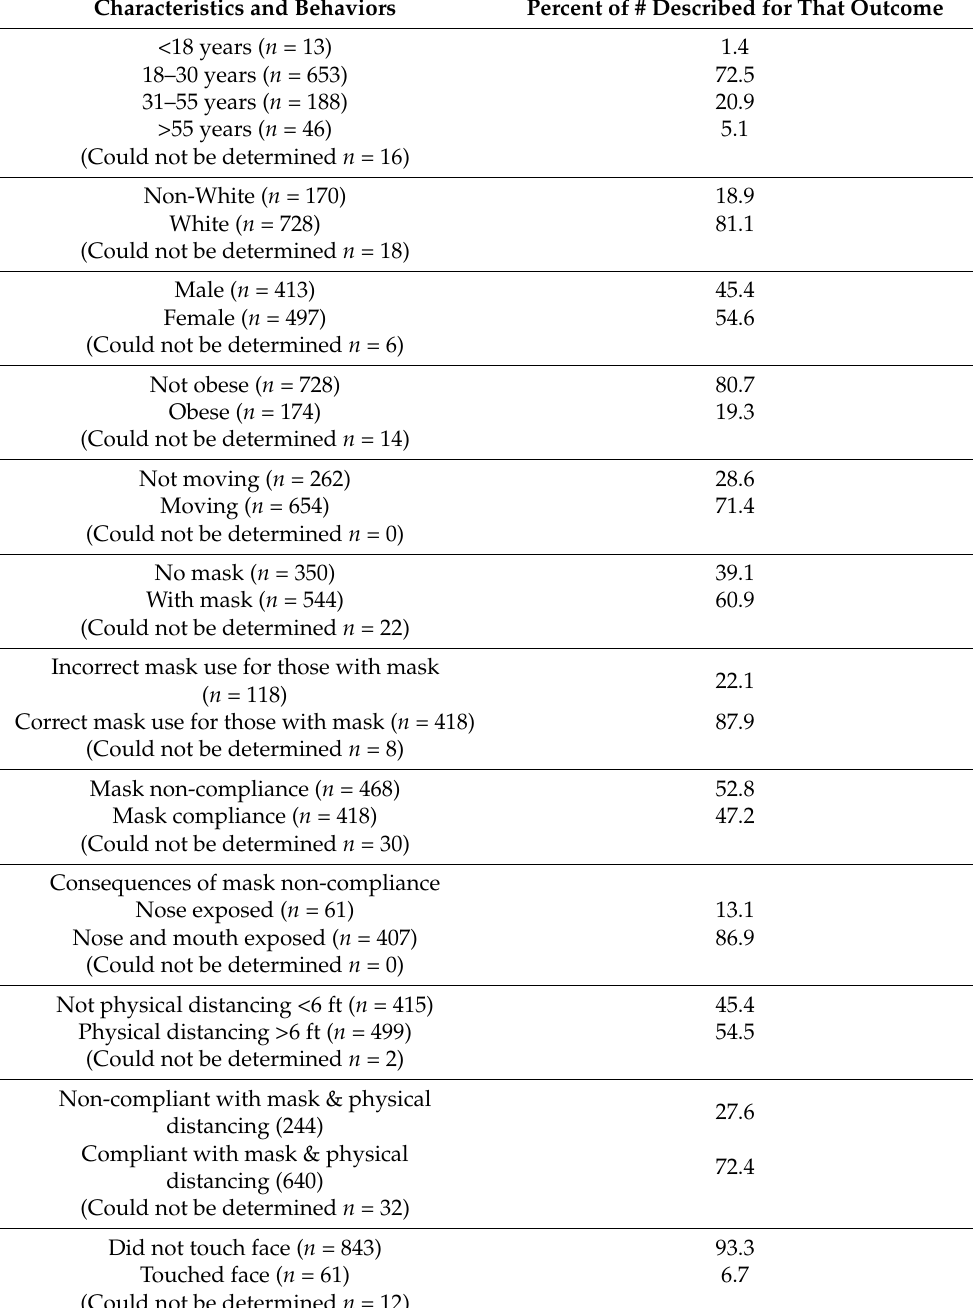
Table 5. Subject characteristics relevant to COVID-19 transmission behaviors ( n = 916 observed). Characteristics and